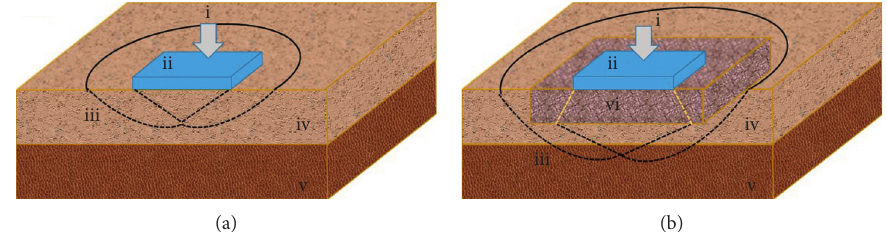
Figure 4: Development of slip surfaces in unreinforced and geocell-reinforced foundations. (a) Unreinforced foundation: (i) upper load, (ii) footing, (iii) failure surface, (iv) sand, and (v) clay. (b) Geocell-reinforced foundation: (vi) geocell